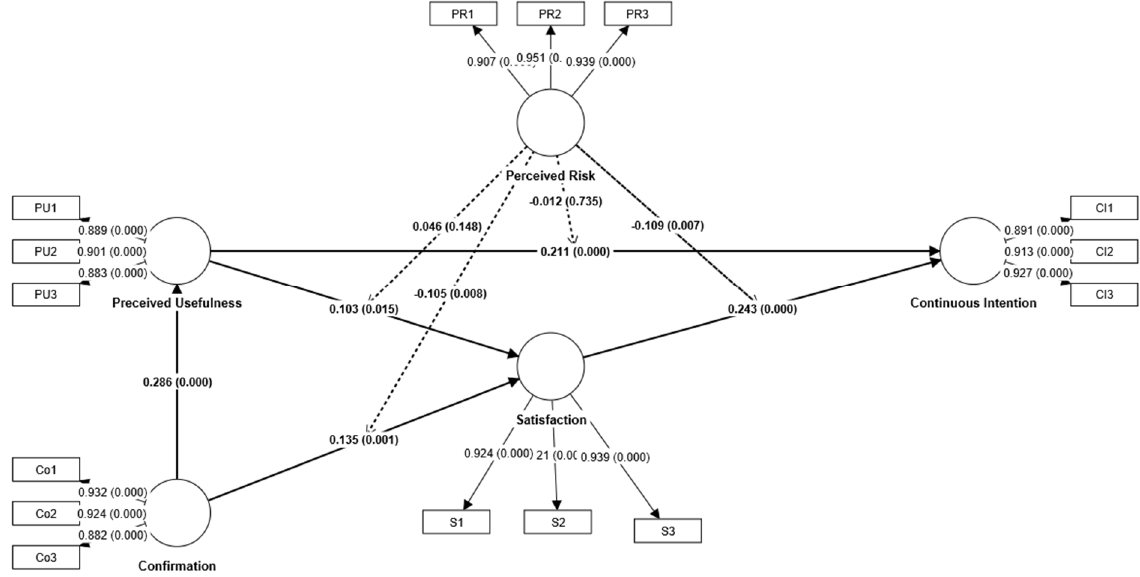
Figure 3. Structural model results. Source: Authors’ Compilations.